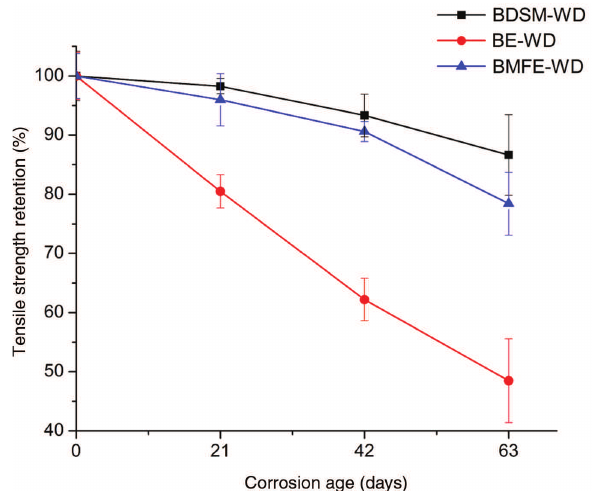
Figure 6: Tensile strength retention.